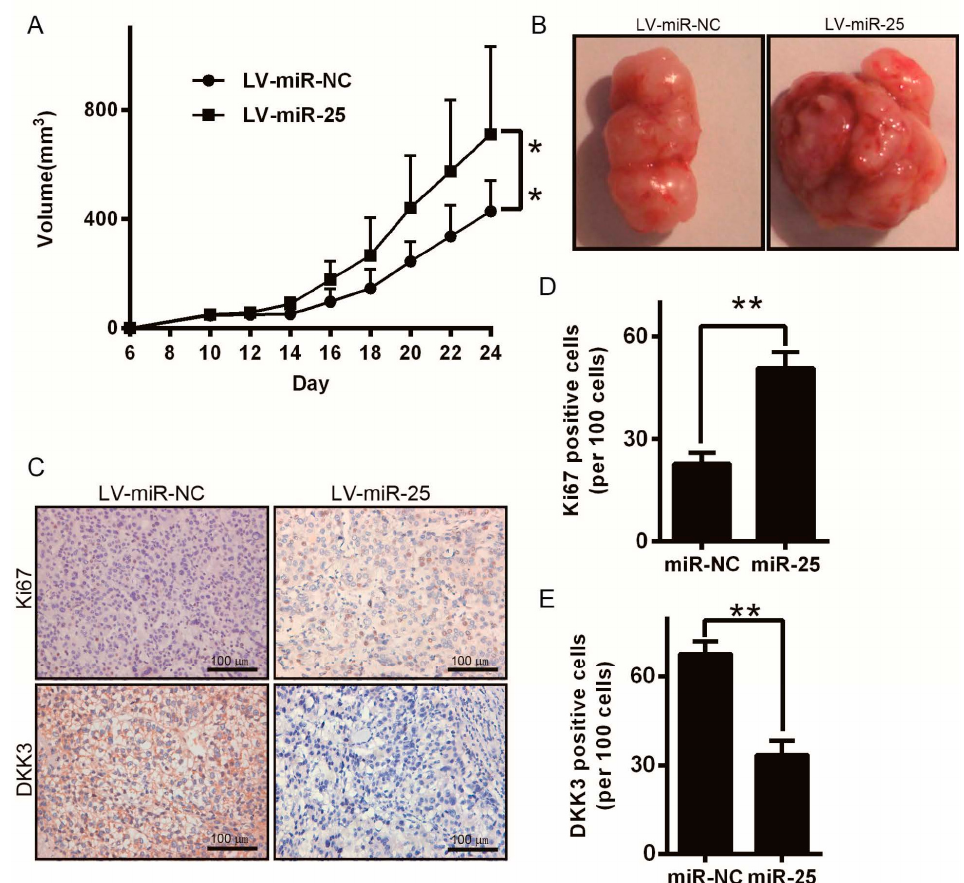
Figure 6. ( A ) A375 cells infected with LV-miR-25 or LV-miR-NC lentivirus were injected subcutaneously into nude mice. From day 6, the tumor sizes were analyzed every other day, and tumor growth curves were measured. Data are presented as the mean ± SD tumor volume; ( B ) twenty-four days after injection of A375 cells, the mice were sacrificed and photographed. Scale bar = 100 μ m; ( C ) immunohistochemical (IHC) staining of Ki67 and DKK3 was performed using serial sections of subcutaneous xenograft tumors; scale bar = 100 μ m; ( D , E ) Ki67 and DKK3 protein levels were measured by IHC in tissue sections from ( C ). ** p < 0.01.